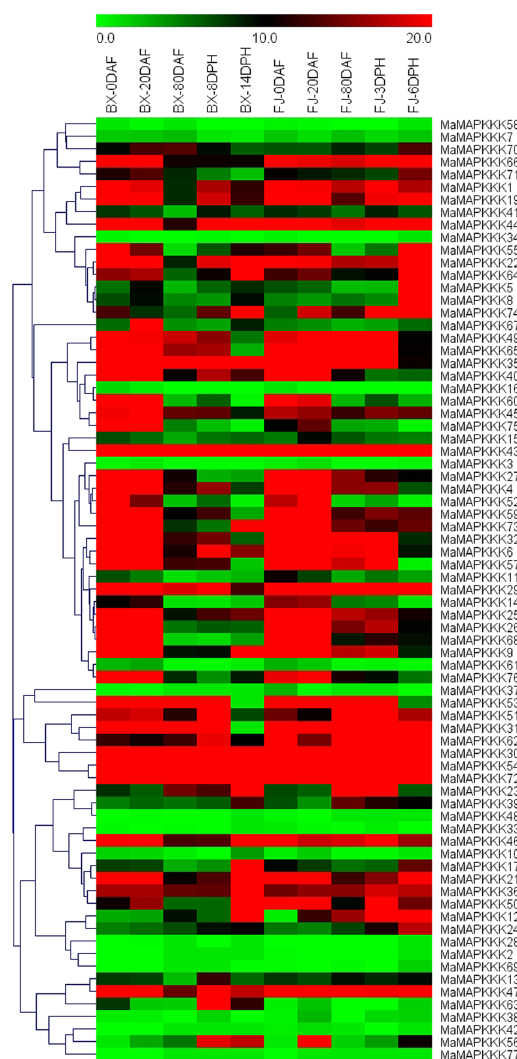
Figure 8. Expression profiles of banana MAPKKKs in different stages of fruit development and ripening in BX and FJ varieties. The heat map was constructed according to the FPKM value of banana RNA-seq data. Changes in gene expression are shown in color as the